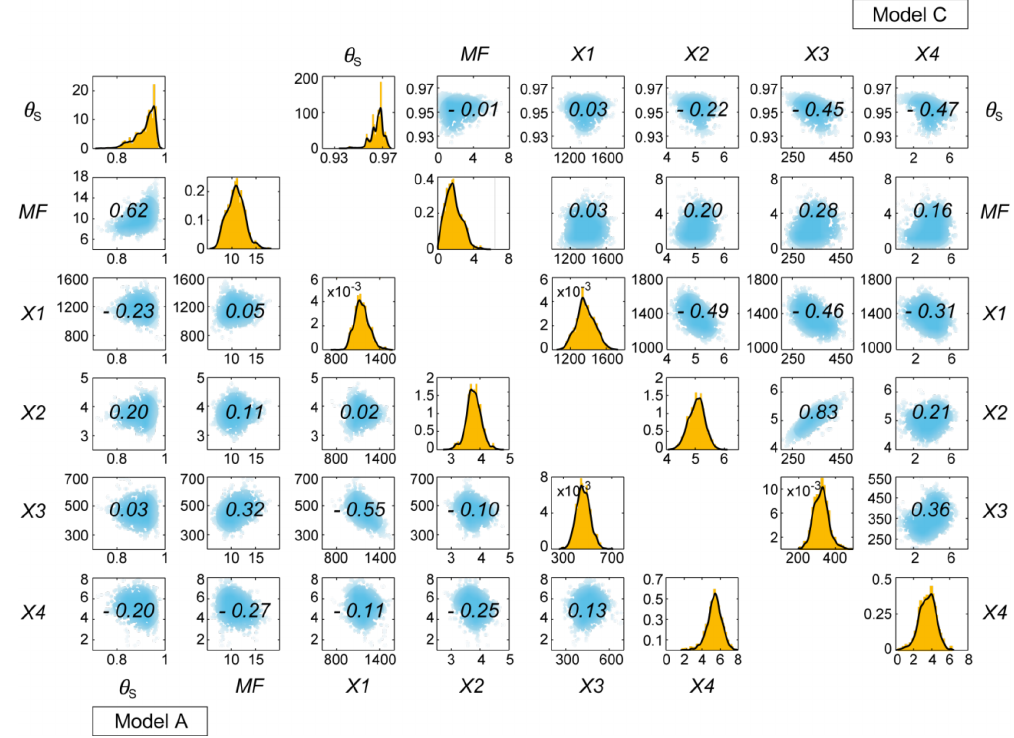
Figure 8. Two-dimensional scatter plots of the posterior parameter samples obtained with Models A and C. The numbers in italic at the center of each cell indicate correlation coefficients. The histograms in orange represent the marginal posterior distributions of parameters with superimposed kernel density estimates. The scatter plots and histograms of Model B were not included here for brevity’s sake, as they were very close to those of Model